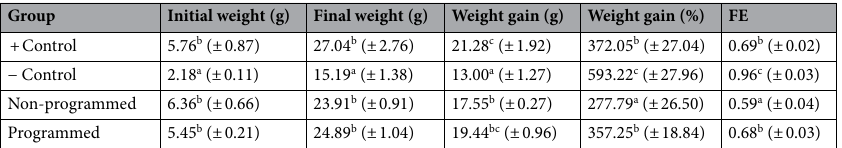
Table 4. Treatment effect on growth performance measures. Average weight represents the final weight of the fish at the conclusion of the study. Weight gain represents the weight gain during the PP-Challenge (79–122 dph). Values are presented as means (± std. dev). Superscript letters indicate statistical significance between groups. The significance was determined using a One-Way ANOVA and a Tukey test with a p value <